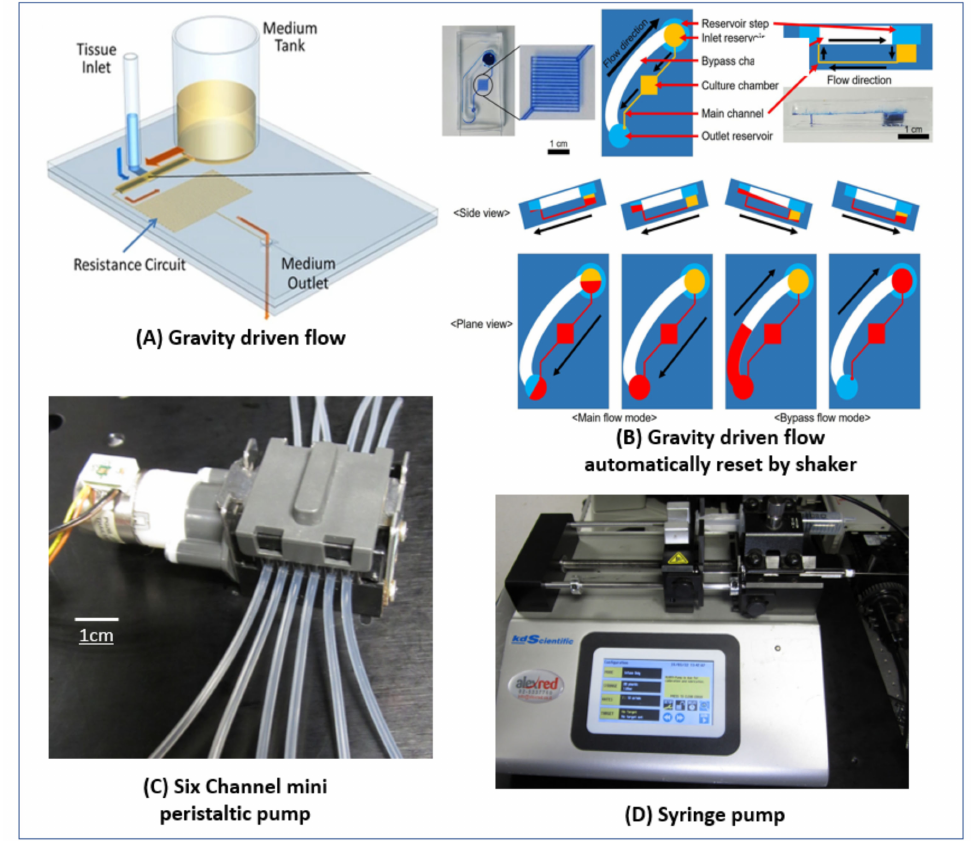
Figure 6. Pumping strategies: ( A ) Testicular tissue fragments were cultured under a membrane in